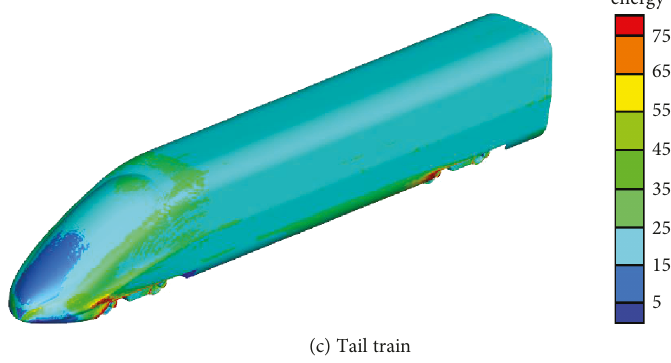
Figure 10: Distribution of turbulence kinetic energy of the bionic train